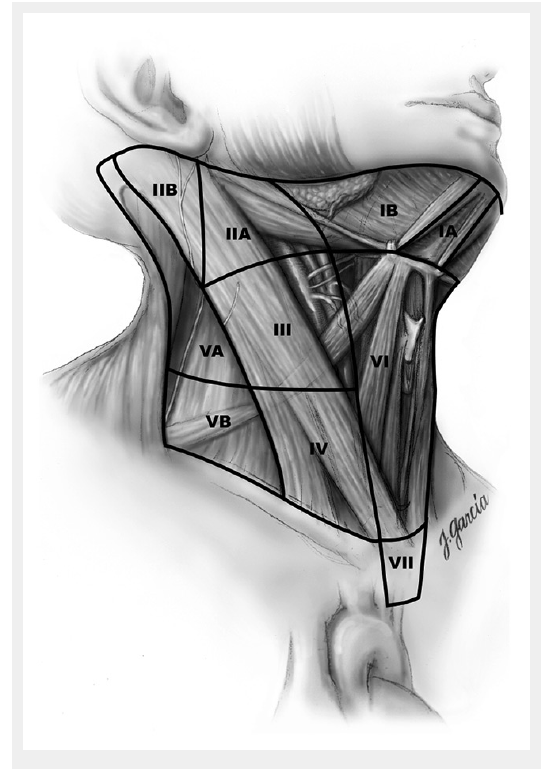
Schematic right anterior oblique view indicating levels of the neck and upper mediastinum relevant to neck dissection in thyroid cancer. Reprinted with permission from Carty SE, et al., Consensus statement on the terminology and classification of central neck dissection for thyroid cancer. Thyroid. 2009;19(11):1153–8. The publisher for this copyrighted material is Mary Ann Liebert, Inc. publishers.